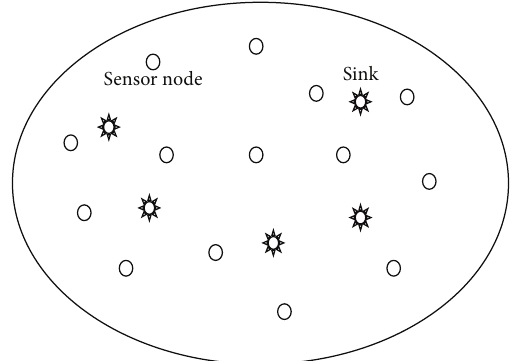
Figure 1: Proposed architecture of multiple mobile